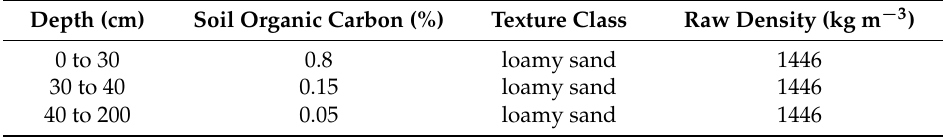
Table 1. Soil characteristics implemented in the MONICA (Model for Nitrogen and Carbon in Agro-ecosystems). The texture class is given according to the World Reference Base (WRB) for Soil